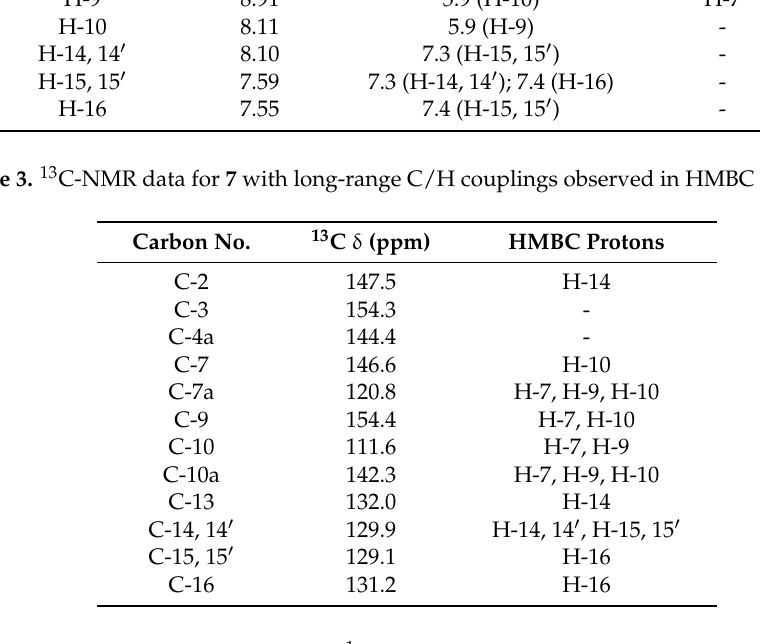
Table 4. 1 H-NMR data for 25 .